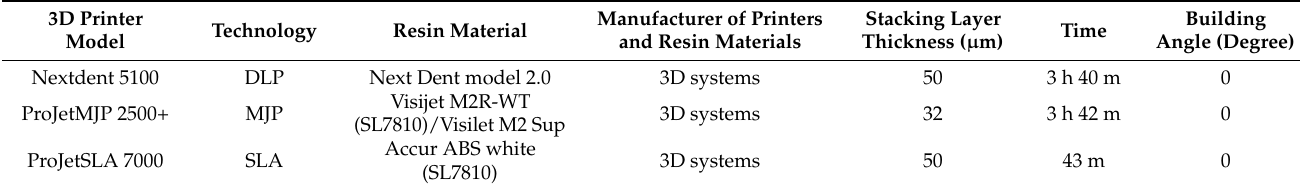
Table 1. Specifications of the 3D printer and materials used in this study.